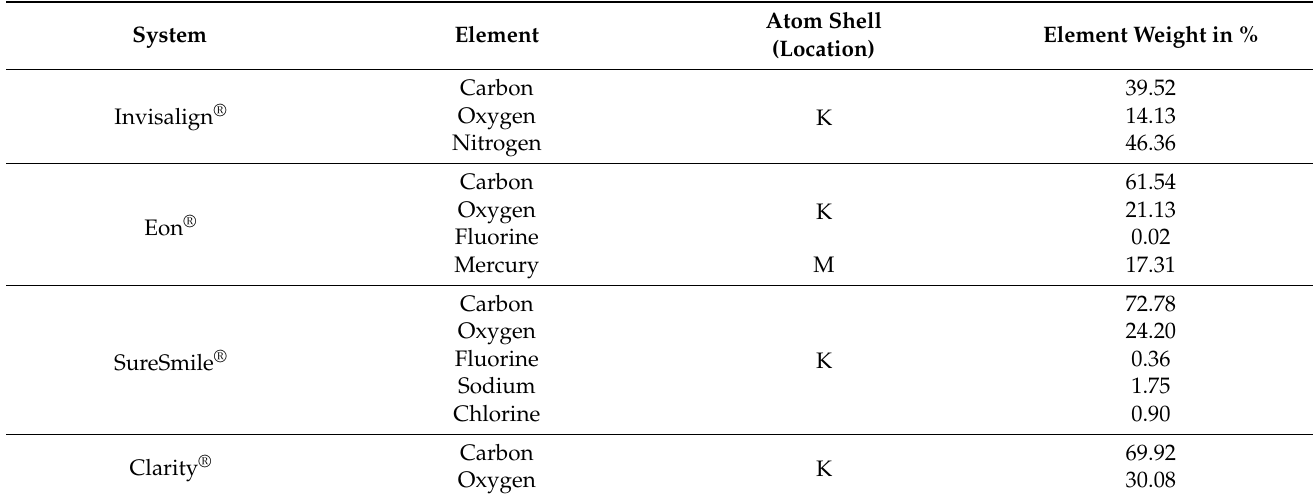
Table 2. Elemental composition and weight of each system (EDX microanalysis).